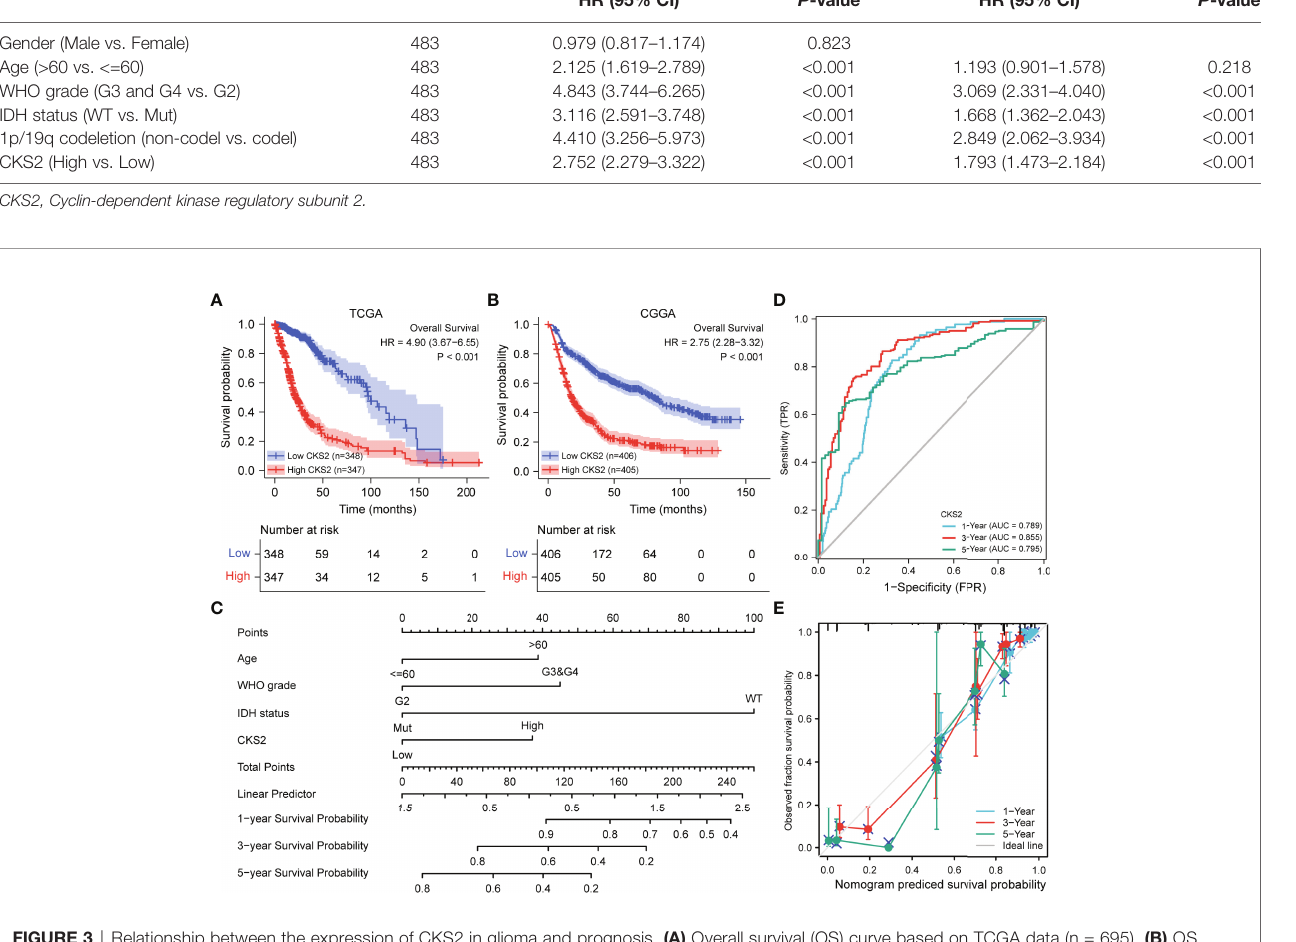
G2M checkpoint ( Figure 5F ), and hypoxia ( Figure 5G ).